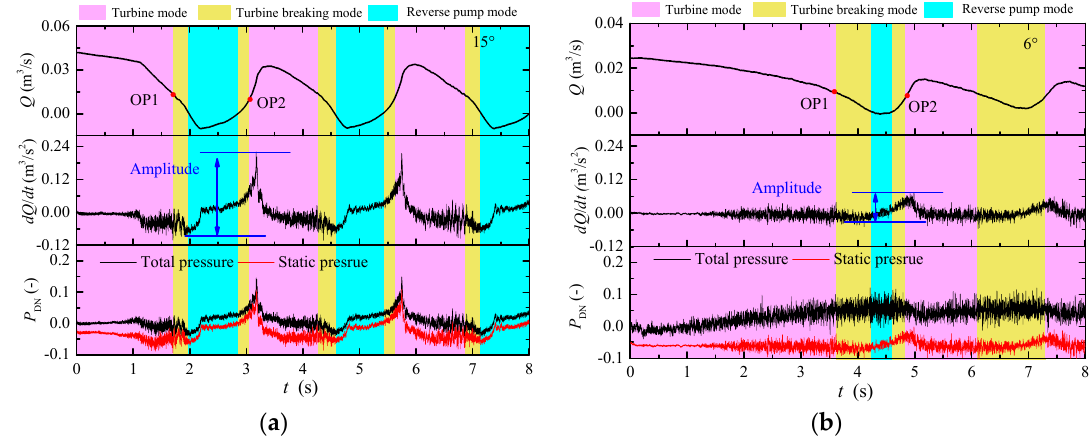
Figure 8. Transient variations of operating parameters for 15° and 6° GVOs. ( a ) 15° GVO; ( b ) 6° GVO.